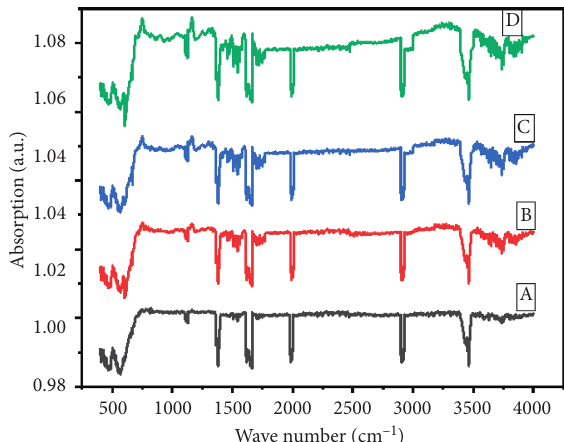
Figure 7: IR pattern of (Ba and y � 0.2 to 0.8 for